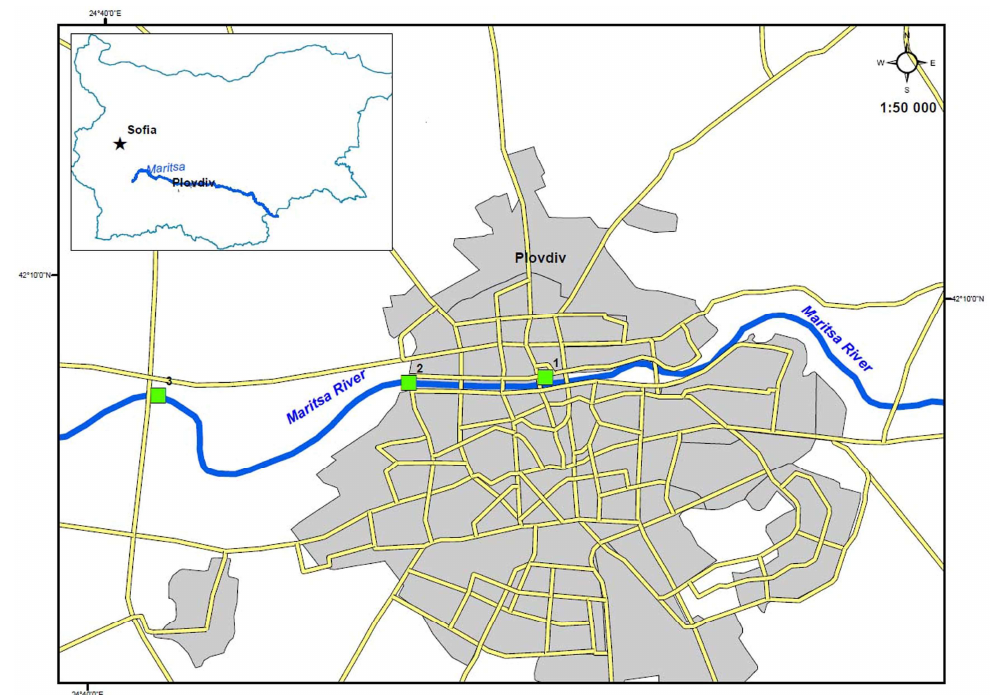
Figure 1. An indicative map of the sites in Plovdiv City, where P. ridibundus individuals were captured in 2020. Legend: 1: urban site; 2: suburban site; 3: rural site. Table 1. Physicochemical properties of the waters of Maritsa River in the three studied sites, for the pe- riod 2017–2019, according to the data of the newsletters of the Basin Directorate of Water Management in the East Aegean Sea—Plovdiv, Ministry of the Environment and Waters (http://www.bg-ibr.org (accessed on 12 January 2023)). Physicochemical data are presented with average annual values and the lowest and highest measured values for each